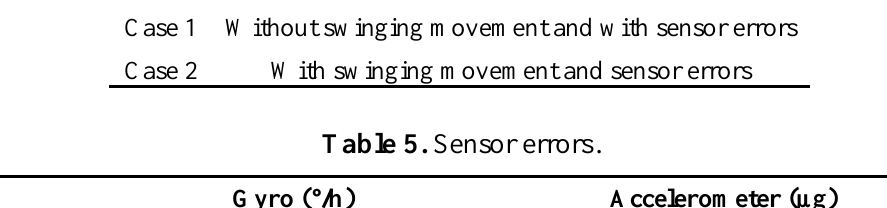
Table 4. Alignment environment.